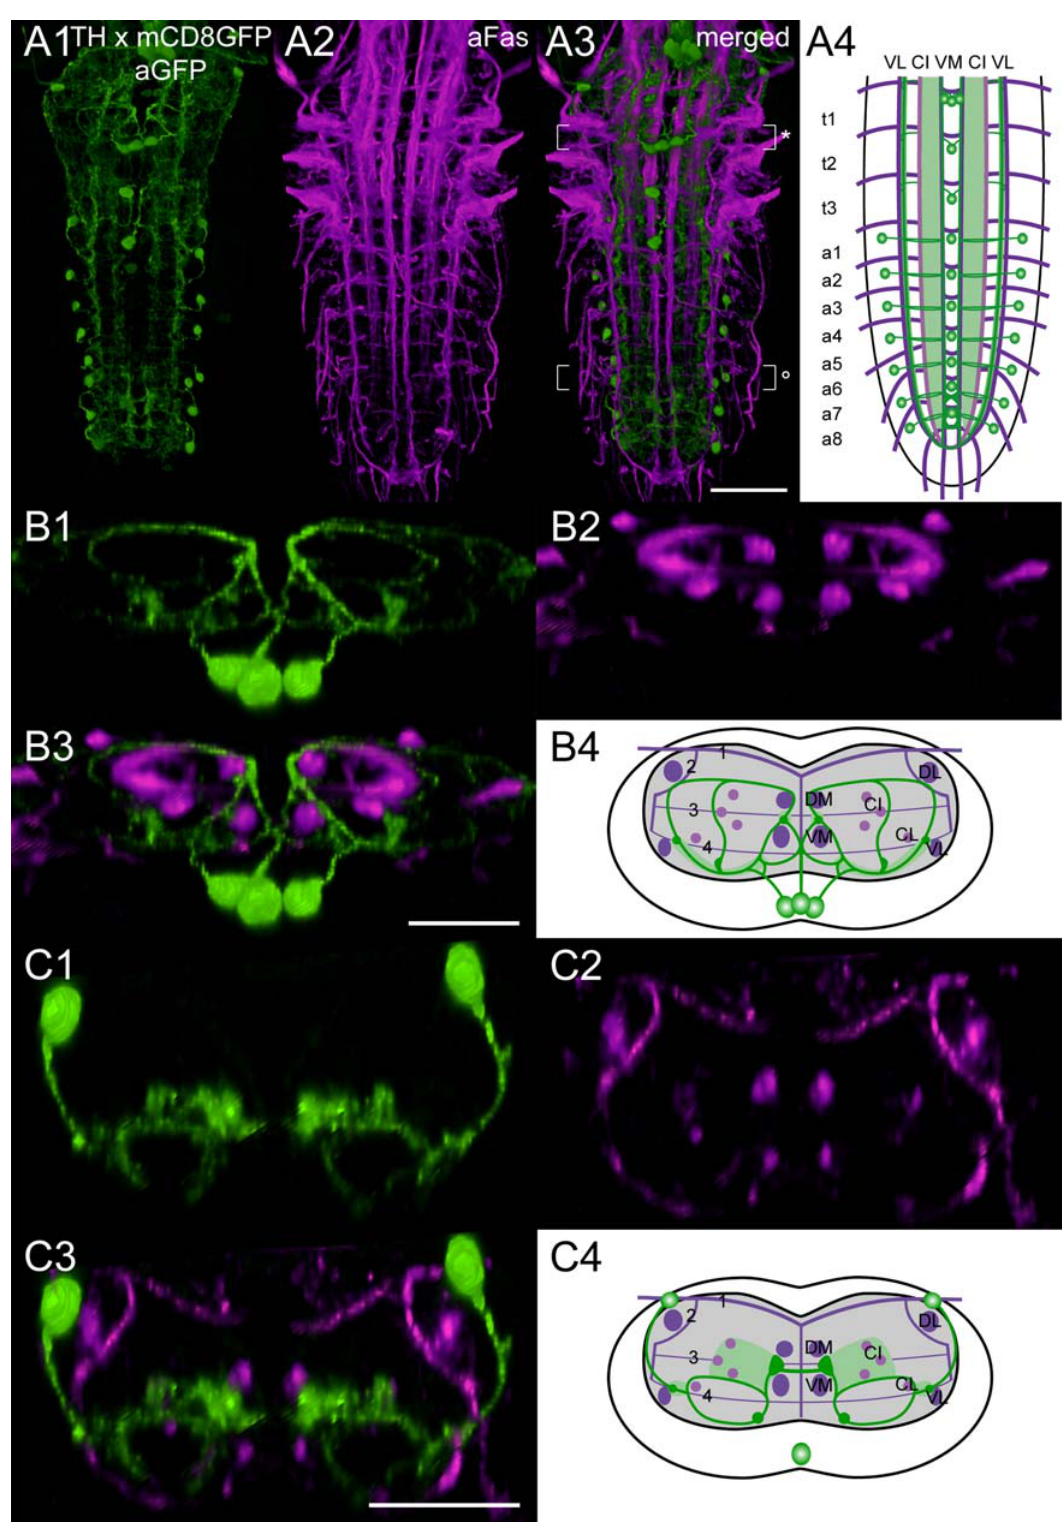
Figure 4. Mapping of Th-gal4 x mCD8GFP expressing neurons. A1) Ventral view of 3D image stacks showing volume-rendered GFP- immunoreactive neurons (green) and A2) Fas2-positive tracts (magenta) in a larva expressing Th-gal4 -driven mCD8GFP. The merged image (A3) served for an idealized schematic representation of Th-gal4 x mCD8GFP expressing neurons in the Fas2 landmark system (A4). B1-3) Corresponding transversal views of the neuromere t1 (* in A3), and B4) the deduced idealized scheme. C1-3) Transversal views, and C4) idealized scheme of a5 ( u in A3). Note that the idealized schemes A4) and C4) include the vmTH neurons of a1-7, which often lacked Th-gal4 -driven mCD8GFP expression. These neurons, however, always showed strong TH immunoreactivity (see Fig. S2). Green-shaded areas in the schemes contain a high concentration of GFP- immunoreactive arborizations. Scale bars: 50 m m in A), 25 m m in B) and C). doi:10.1371/journal.pone.0001848.g004 PLoS ONE |